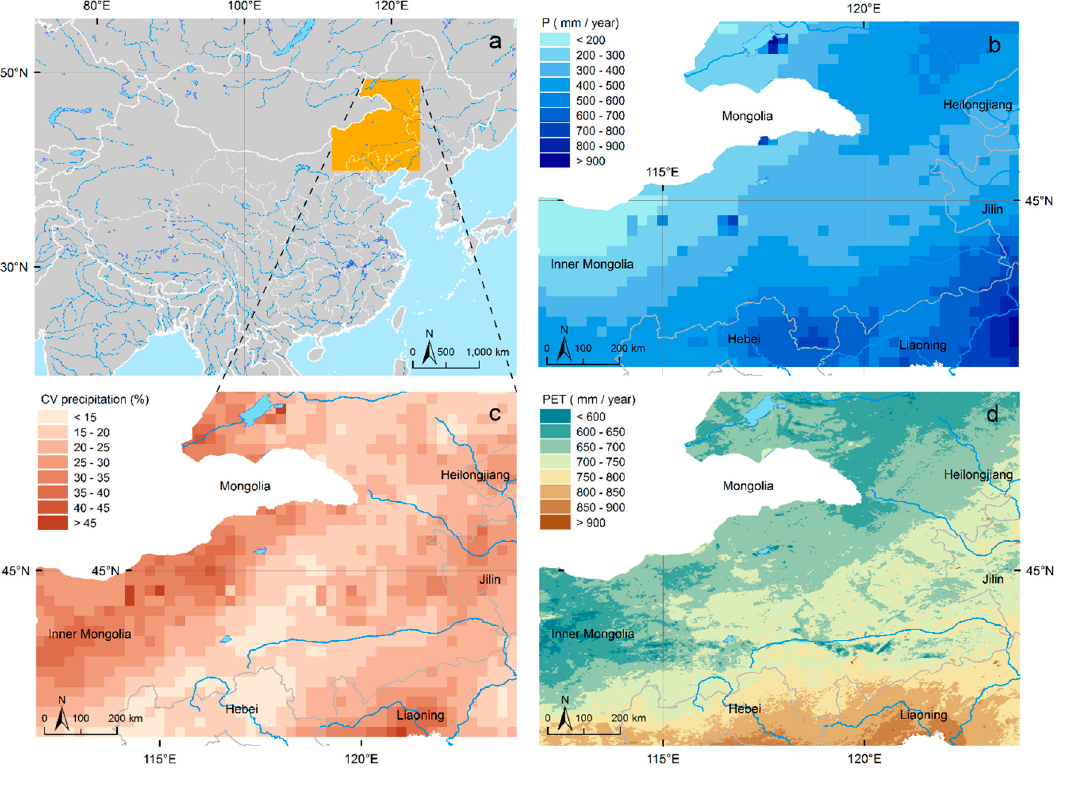
Figure 1. ( a ) Location of the study region in the northeast of China; ( b ) mean cumulative precipitation (mm·year − 1 ); ( c ) Coefficient of Variation (CV) of precipitation (%); ( d ) mean potential ET (mm·year − 1 ).